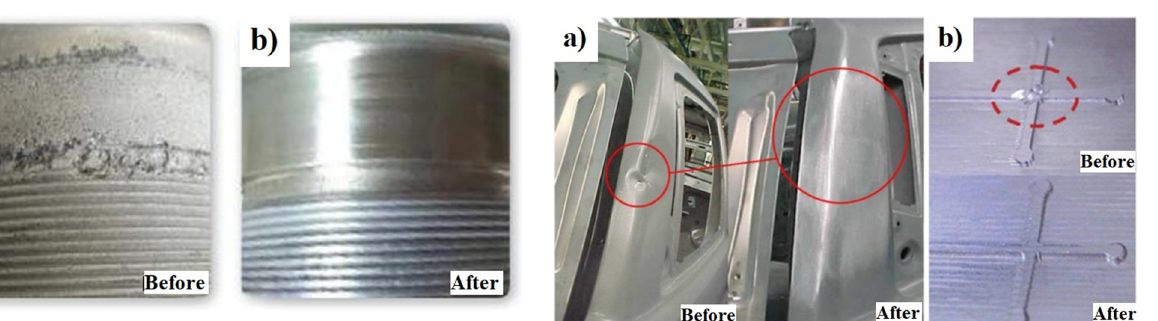
Figure 22: Comparing the deteriorated and restored parts by CSAM: